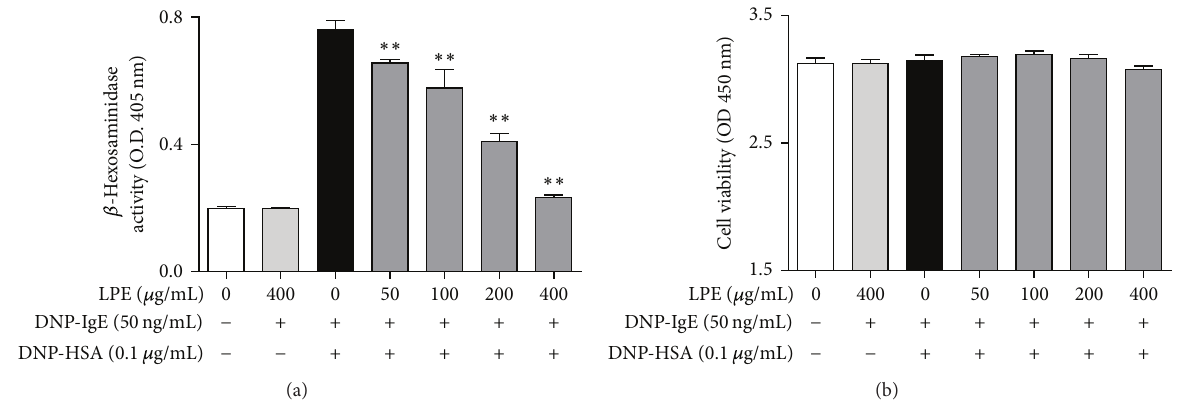
Figure 1: Effect of LPE on degranulation and cell viability in IgE-mediated RBL-2H3 cells. RBL-2H3 cells were seeded on a 24-well plate (1 × 10 5 cells/well) or a 96-well plate (1 × 10 4 cells/well) in MEM- 𝛼 with 10% FBS at 37 ∘ C overnight and further incubated with DNP-IgE for 24 h. IgE-sensitized cells were preincubated with LPE (0 to 400 𝜇 g/mL) for 1h and then stimulated with DNP-HSA (0.1 𝜇 g/mL) for 4 h. 𝛽 -Hexosaminidase activity and cell viability were determined as described in Section 2. Data are the mean ± SD values of triple or octuple determinations. ∗∗ 𝑃 < 0.01 versus DNP-HSA-treated group. (a) 𝛽 -Hexosaminidase; (b) cell